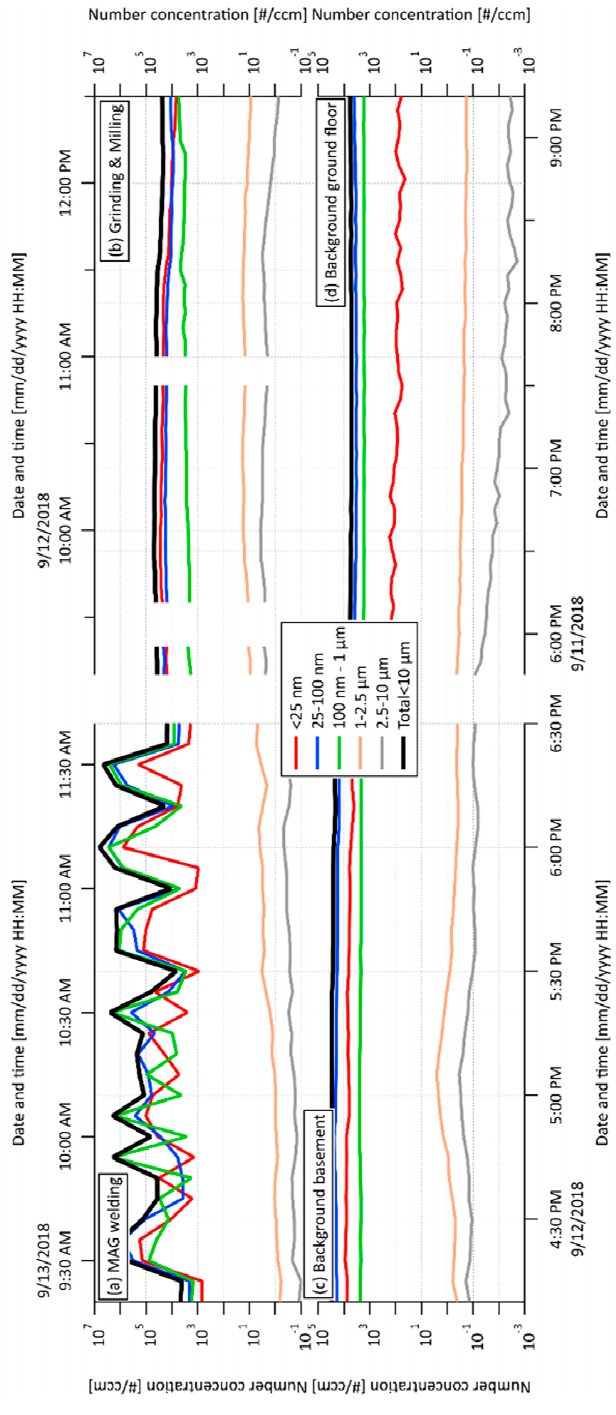
Figure 1. Scanning Mobility Particle Sizer ( SMPS) + Aerodynamic Particle Sizer ( APS) concentration in wider size bins related to ( a ) metal active gas (MAG) welding process in workshop 1; ( b ) grinding and milling processes in workshop 2; ( c ) background, basement; ( d ) background, ground floor.